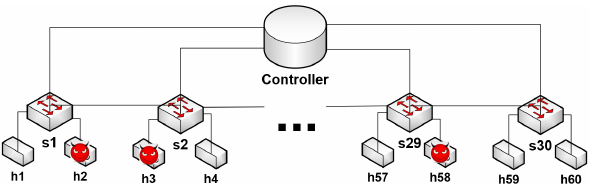
Figure 3. Network architecture in the Mininet.